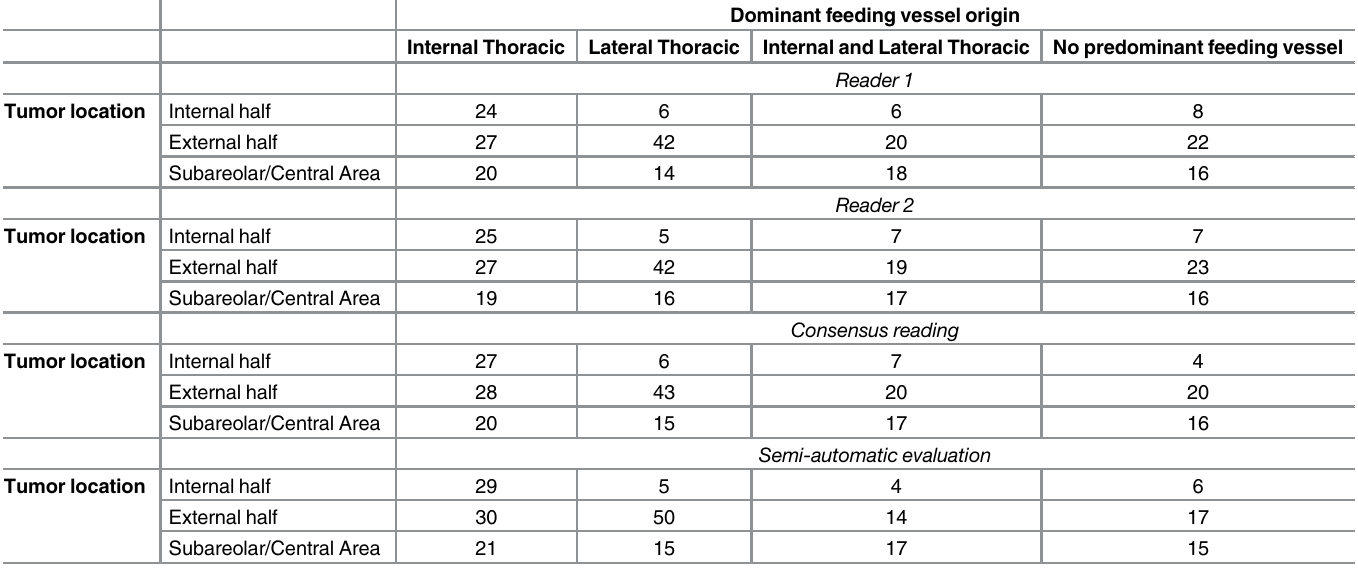
Table 5. Tumor location and dominant feeding vessel origin findings for single reader, for consensus reading and for semi-automatic evaluation. Table entries: number of